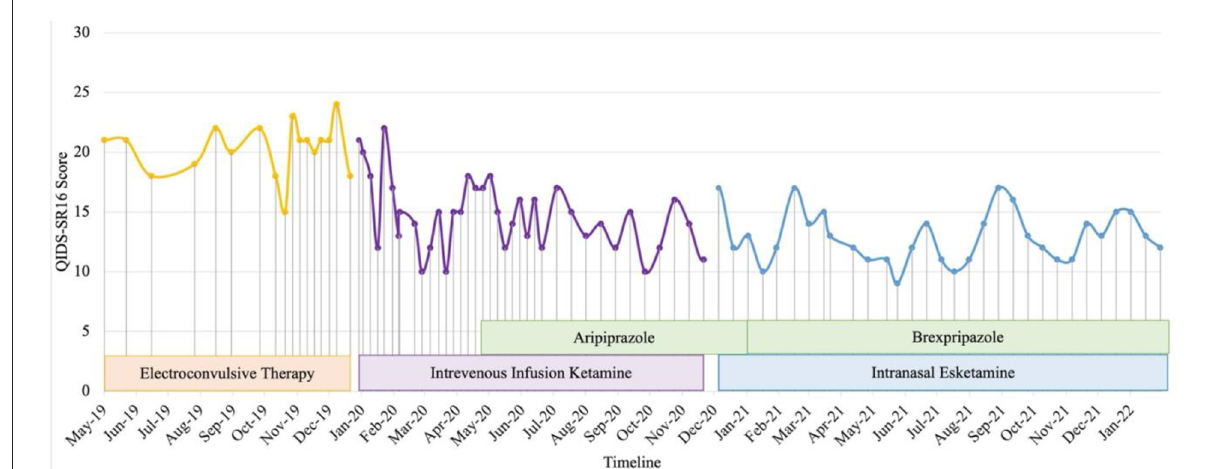
FIGURE4 Case 4 timeline for longitudinal course of treatment response. Patient 4 is a woman in her 40’s with a current diagnosis of treatment-resistant unipolar depression with physical co-morbidity of congenital glaucoma and bilateral complete vision loss. Brexpiprazole was initiated at the dose of 0.5mg and titrated to a maximum of 1mg in combine with intranasal esketamine 84mg fortnightly. Co-medications include mirtazapine 30mg, agomelatine 50mg. Her mood stability and functionality improved with the combination of brexpiprazole and esketamine in